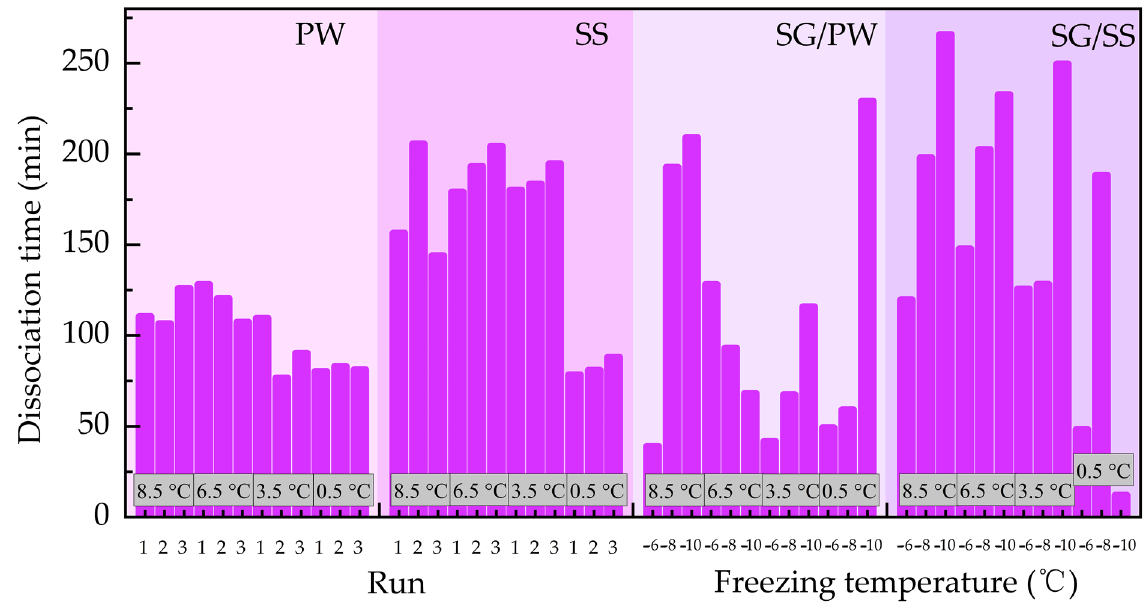
Figure 8. Total dissociation times in all experimental runs. Specific values are listed in Table S1.